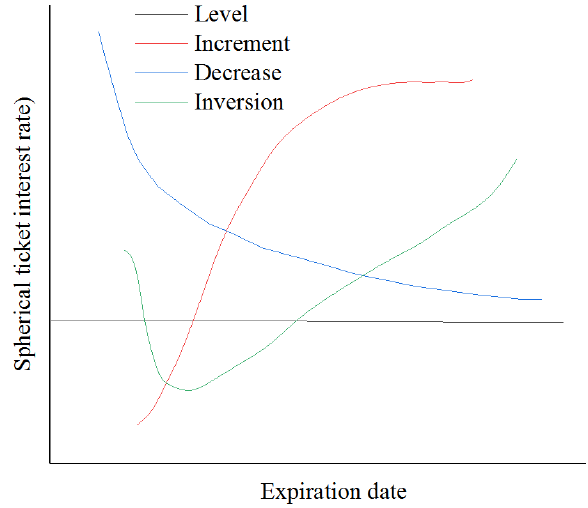
Fig. 2 The yield curve that the Nelson-Siegel model can